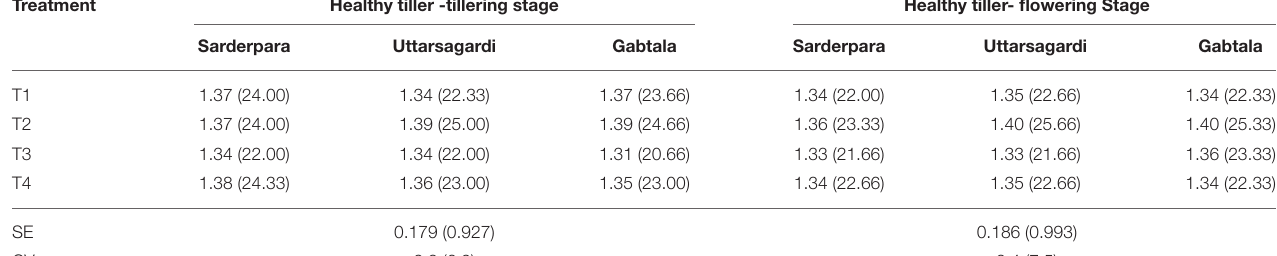
TABLE 7 | Interation effect of location and treatement on tillers, hills, dead heart, white head and yield of rice crops in 2012-13.